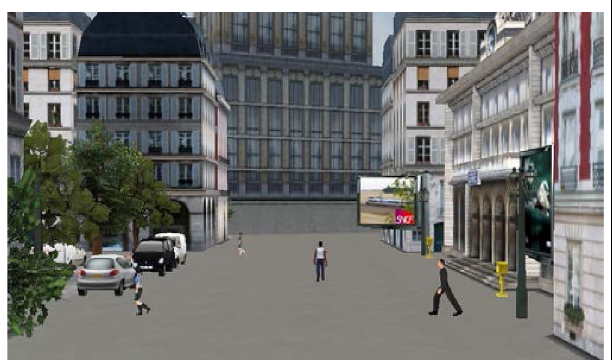
FIGURE 1 |The virtual town: a view on a pedestrian path with some people walking, buildings, and street